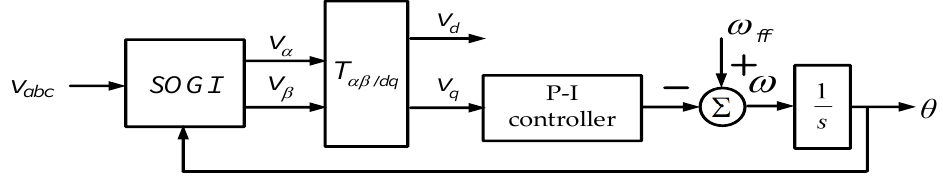
Figure 7. Block diagram for phase estimation using a SOGI-based PLL system.